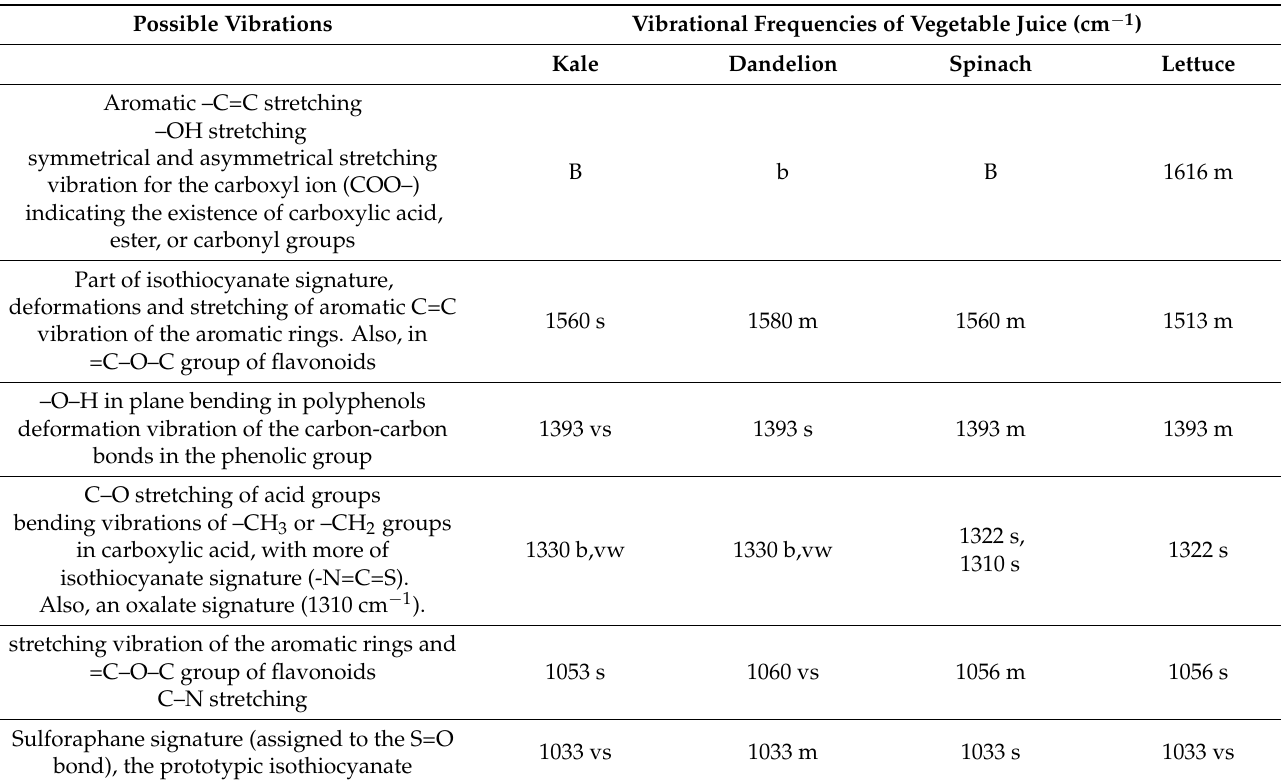
Table 2. Peaks with significant intensities in the Attenuated Total Reflection–Fourier Transform Infra-Red (ATR-FTIR) spectra of the vegetable juices (kale, dandelion, spinach, and lettuce). Possible Vibrations Vibrational Frequencies of Vegetable Juice (cm − 1 ) Kale Dandelion Spinach Lettuce